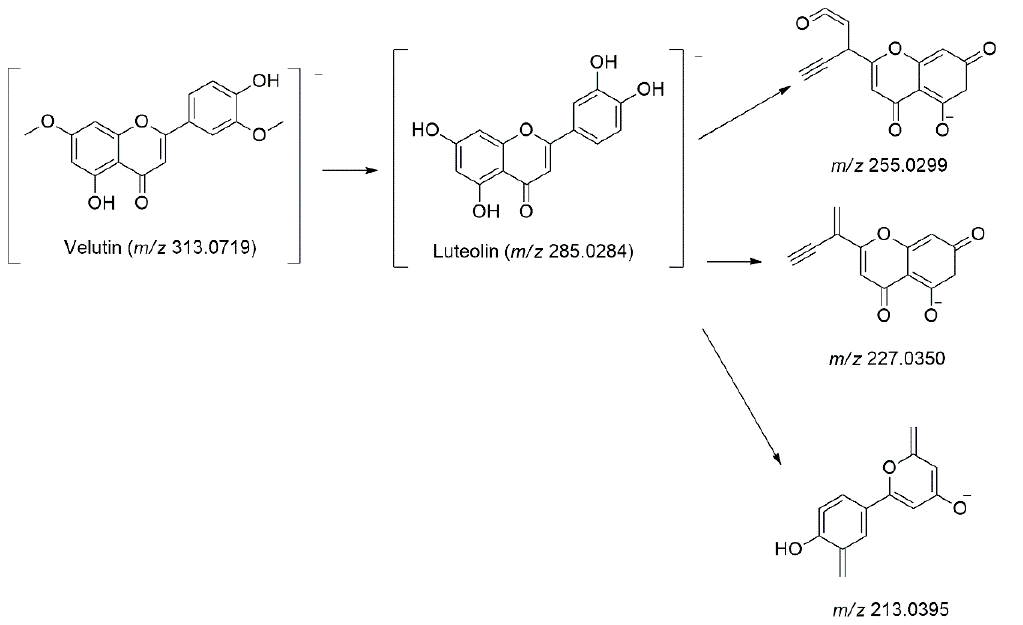
Figure 6. The fragmentation pathways of the luteolin derivatives.